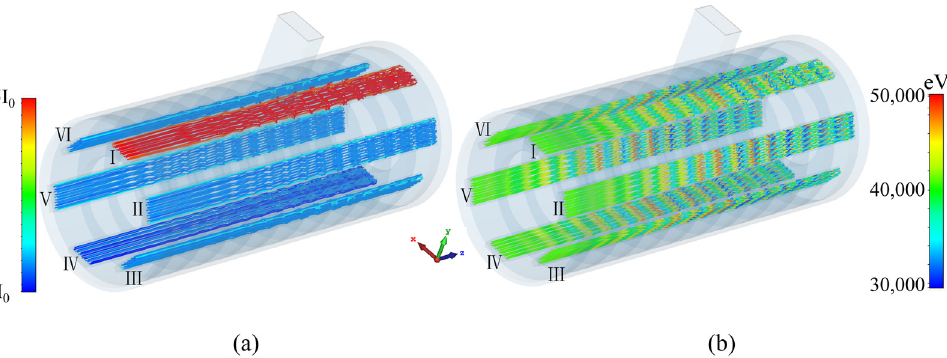
Figure 10. ( a ) Electron beam distribution and ( b ) corresponding beam trajectory with the current of 5I 0 for beam Ⅰ and the current of I 0 for other beams.